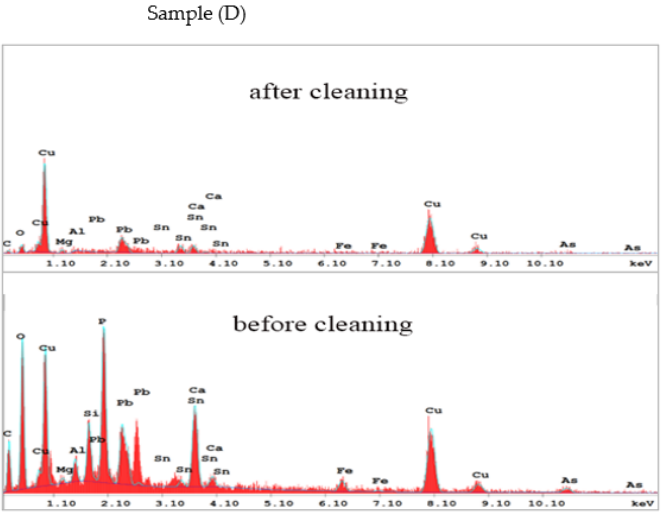
Figure 16. The EDX analysis of the coin (D) before and after laser cleaning. Table 1. Mass percentage values of the elements of the coins’ corroded layer before and after cleaning determined by EDX.